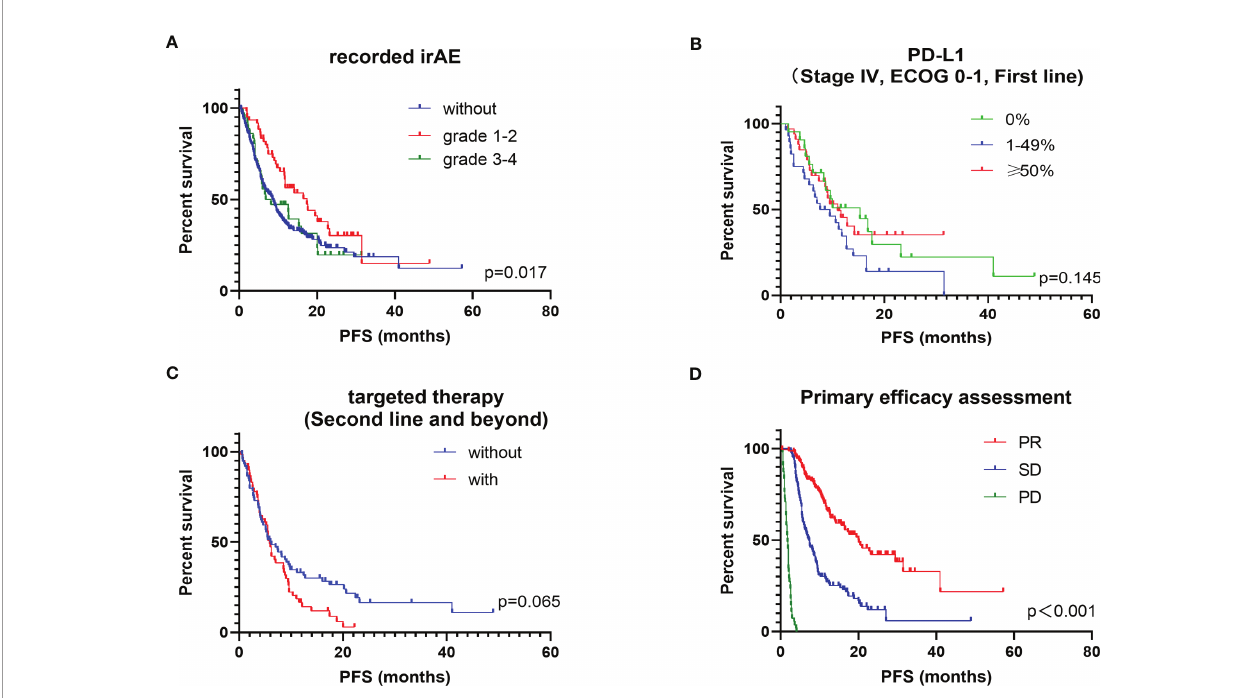
FIGURE 2 | Kaplan-Meier plot of PFS for subgroups of interest. (A) strati fi ed according to recorded irAEs; (B) strati fi ed according to PD-L1; (C) strati fi ed according to targeted therapy history in post-line patients; (D) strati fi ed according to primary ef fi cacy